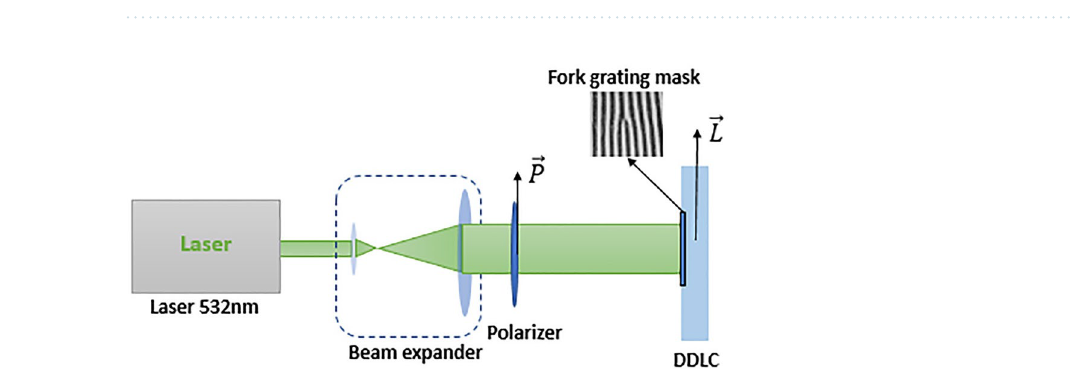
Figure 3. The absorption spectrum of the sample in two states, the linear incident light polarization, −→ P , parallel and perpendicular to the alignment direction of the cell, −→ L .